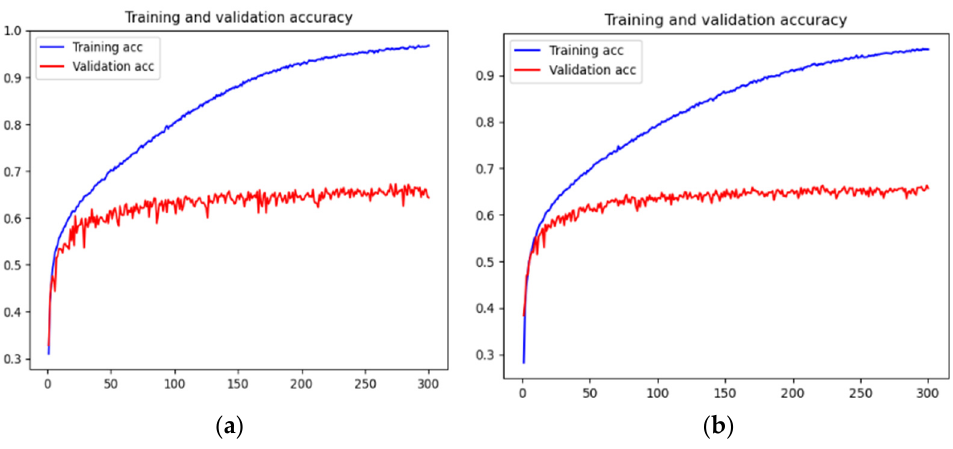
Figure 8. Acc curve. ( a ) VGG16 training acc curve; ( b ) Add ECANet’s VGG16 model training acc curve.